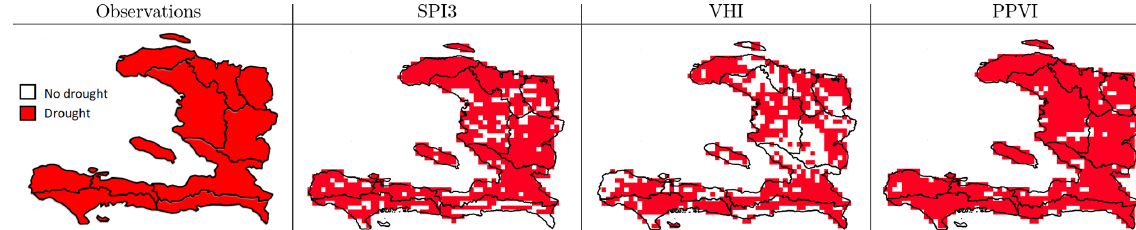
Figure 9. Same as Fig. 8 but for week 33 of 2015. Departments highlighted in red are the ones in drought according to observations; red cells are the ones in drought conditions according to the various